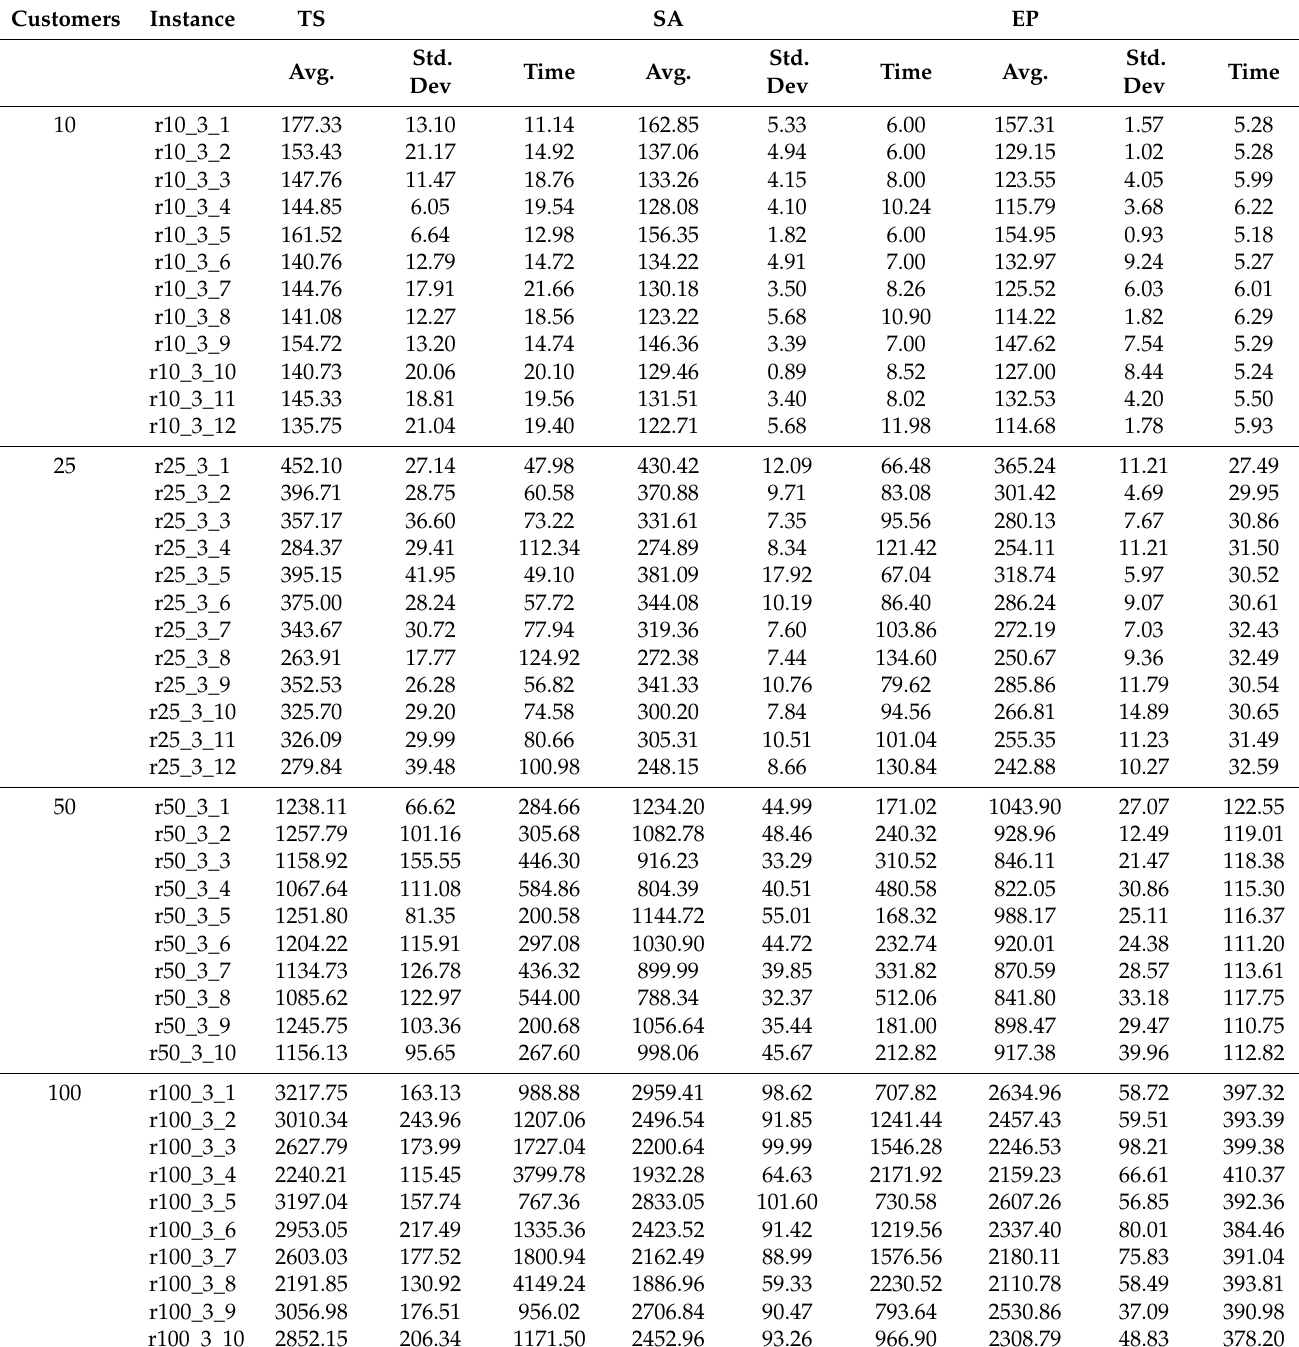
Table 3. Performance measures of metaheuristic